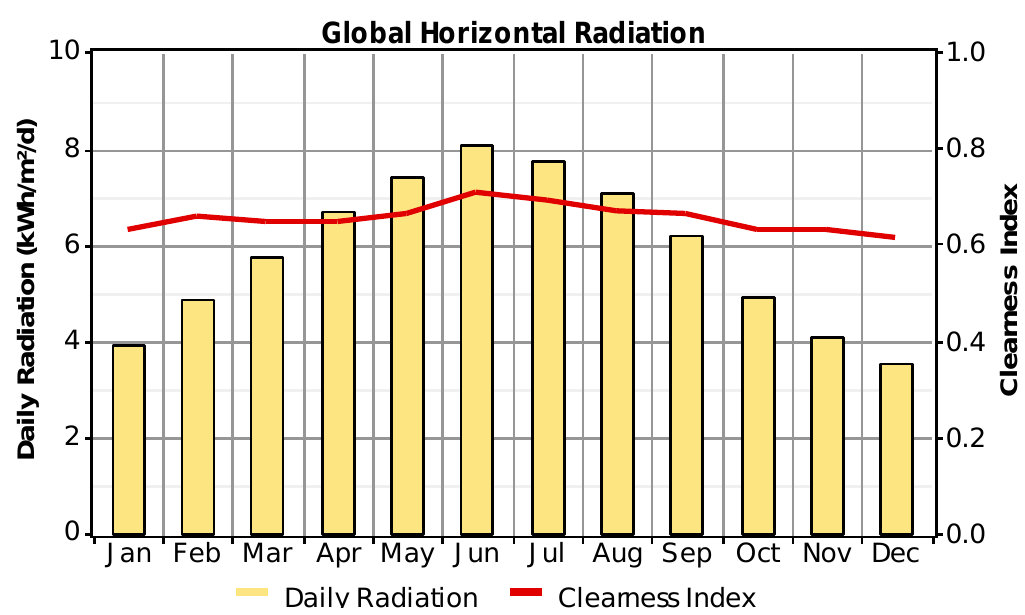
Figure 6. Average daily solar radiation and clearance index during each month.